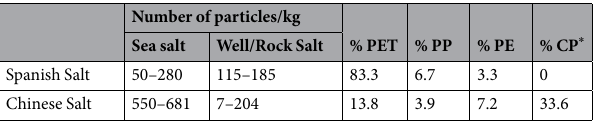
Table 2. Comparison of the results of the present study with Yang et al . (2015) study on Chinese salts. * Cellophane